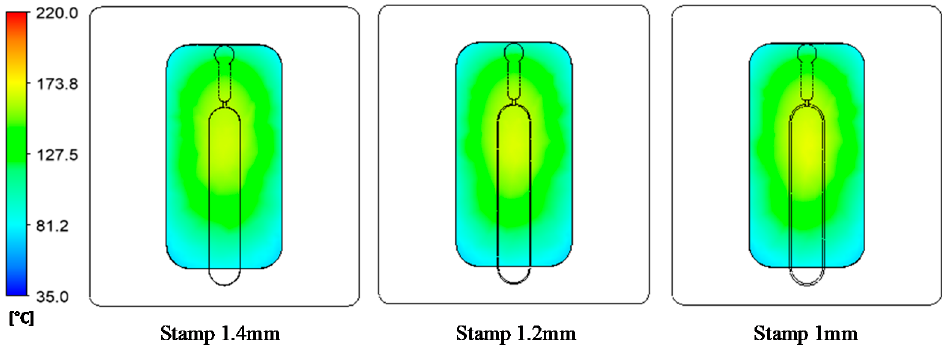
Figure 9. Temperature distribution of the molding area with an initial temperature of 40 ◦ C, a gas temperature of 300 ◦ C, an inlet gas pressure of 7 bars, and a heating time of 20 s.